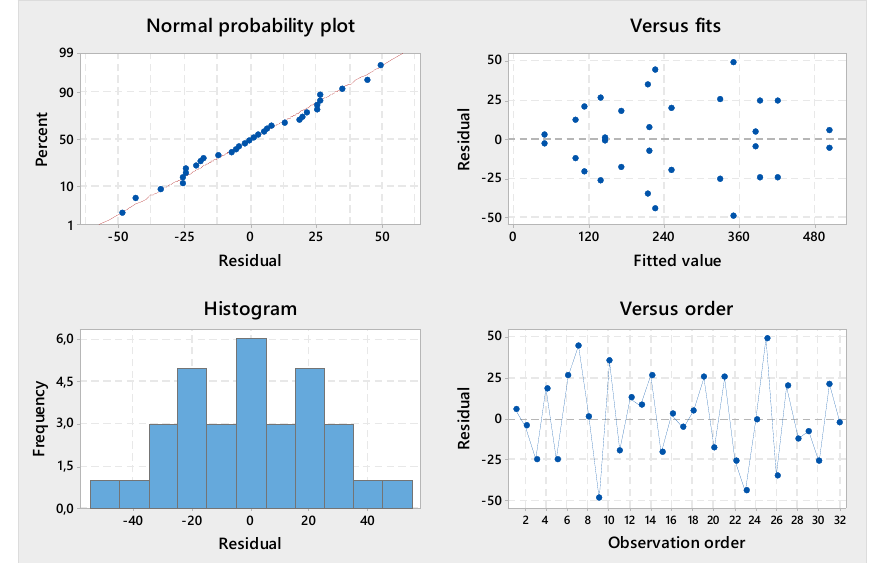
Figure 2. Residual analysis of chips for particle sizes.